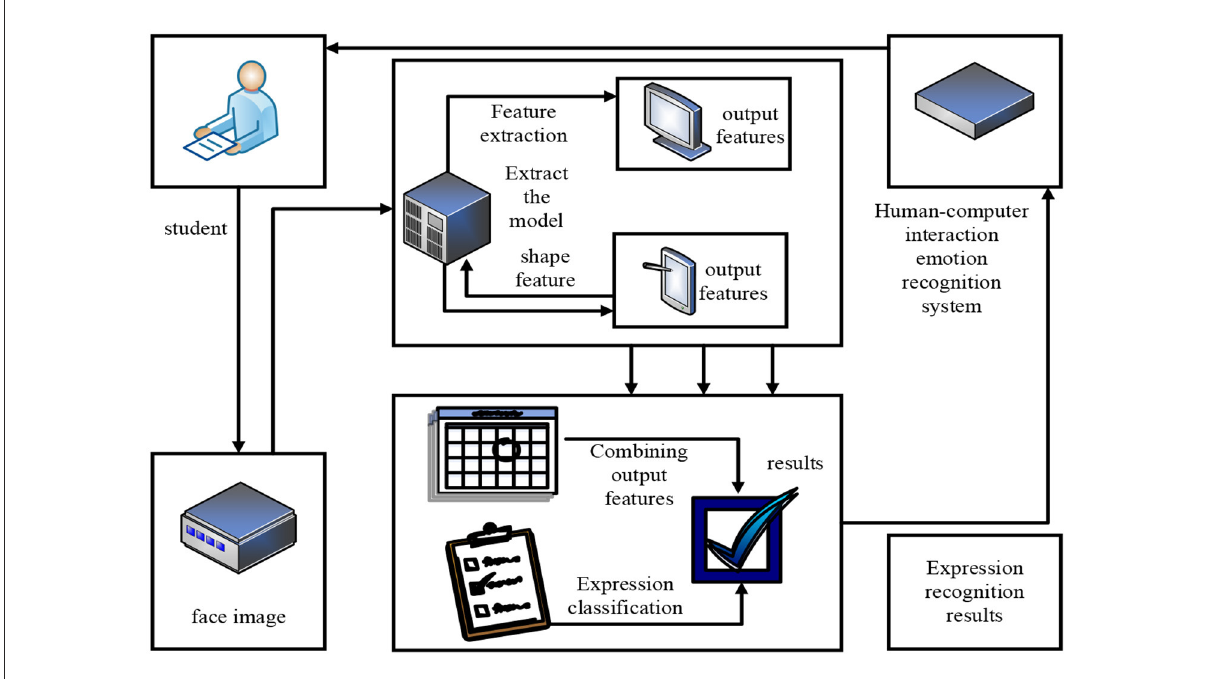
FIGURE1 The overall framework of human-computer interaction emotion recognition.